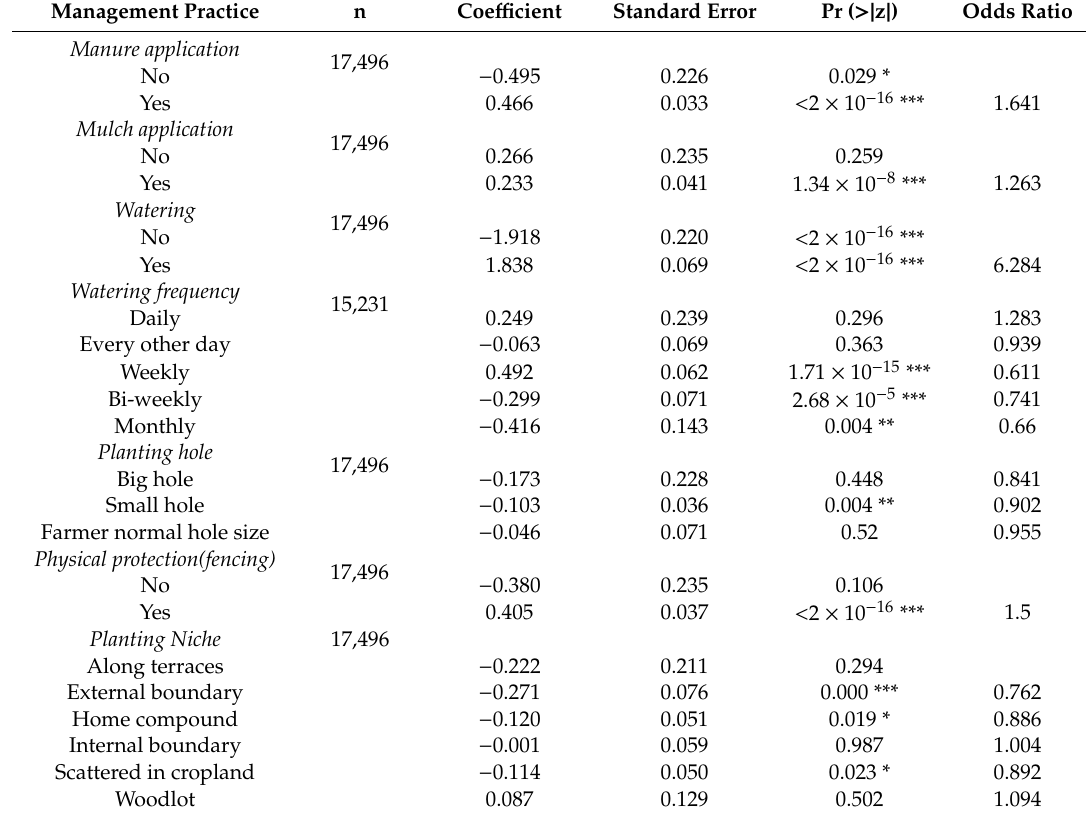
Table 4. Results of a logistic model on the probability of seedling survival under di ff erent planting and